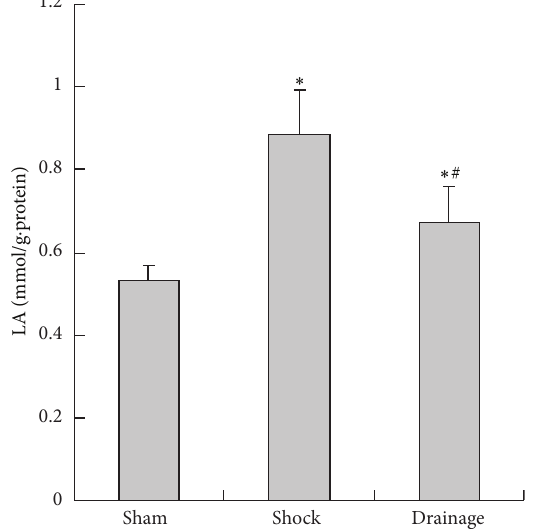
Figure 4: Effects of mesenteric lymph drainage on LA content of renal homogenate in hemorrhagic shock rats without resuscitation (mmol/g ⋅ protein, mean ± SD, 𝑛 = 6 ). ∗ 𝑃 < 0.05 versus sham group; # 𝑃 < 0.05 versus shock group.